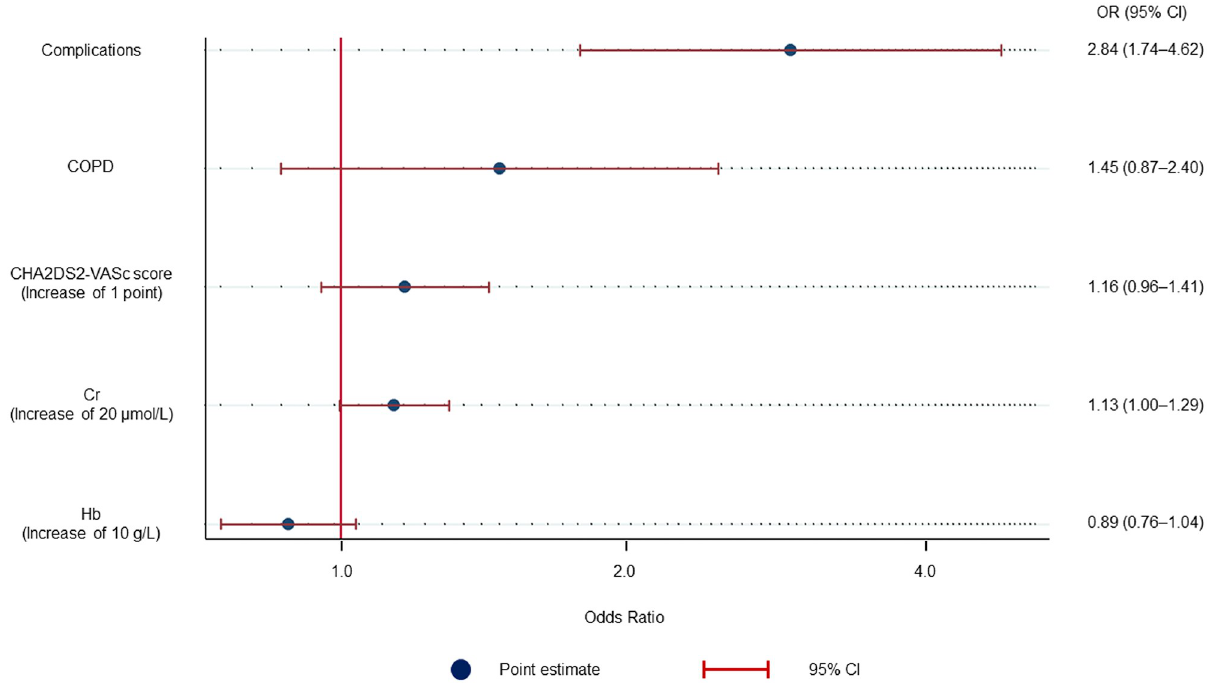
Fig 1. Multivariate logistic regression analysis for POAF development. Any 30-day complications were associated with POAF development. CI, confidence interval; COPD, chronic obstructive pulmonary disease; Cr, creatinine; Hb, hemoglobin; OR, odds ratio; POAF, perioperative atrial